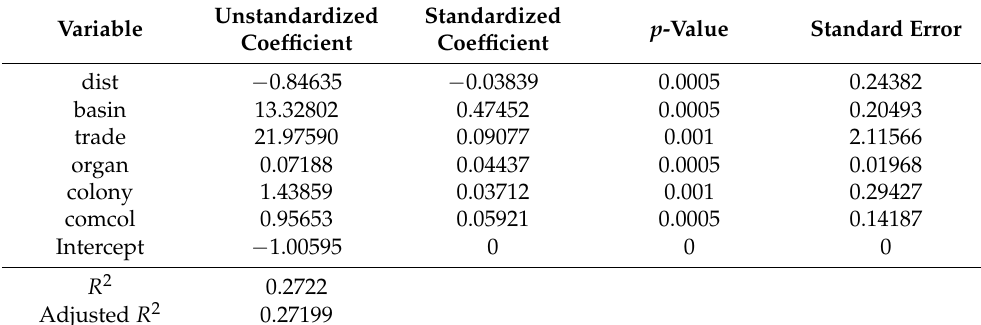
Table 4. QAP multiple regression